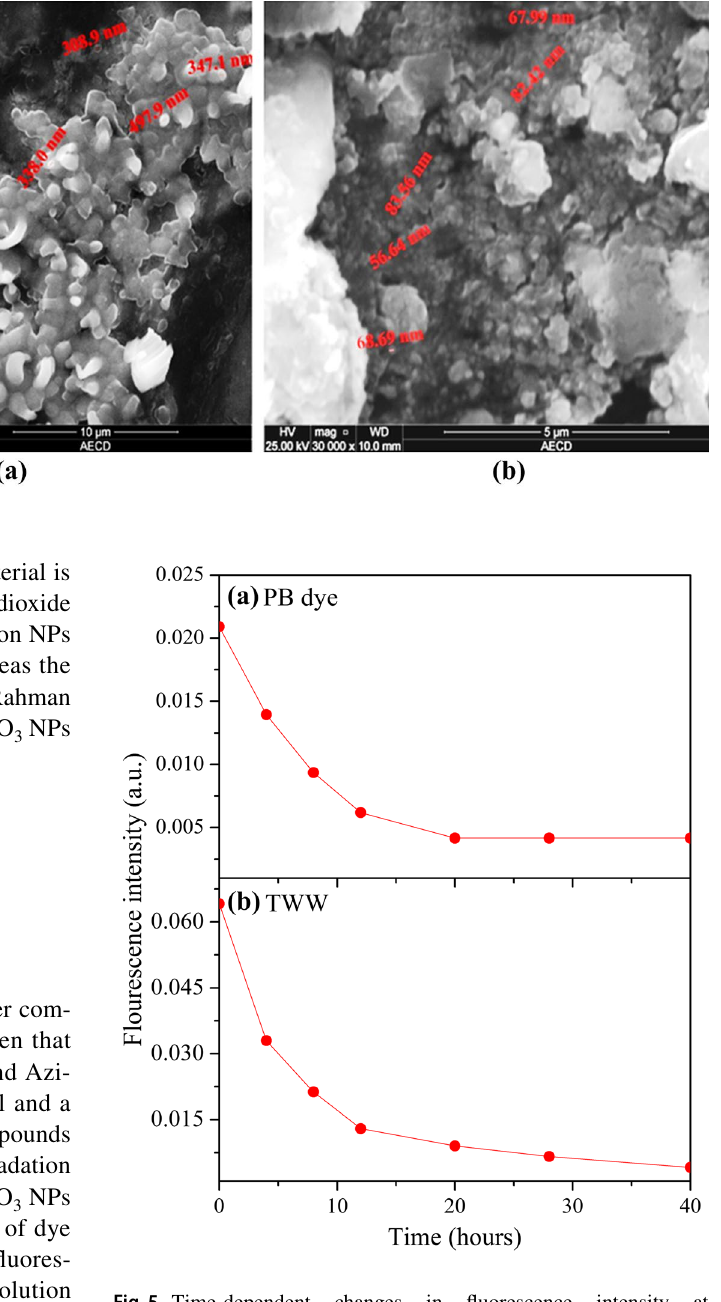
Fig. 5 Time-dependent changes in fluorescence intensity at 350 nm/450 nm of the PB dye and